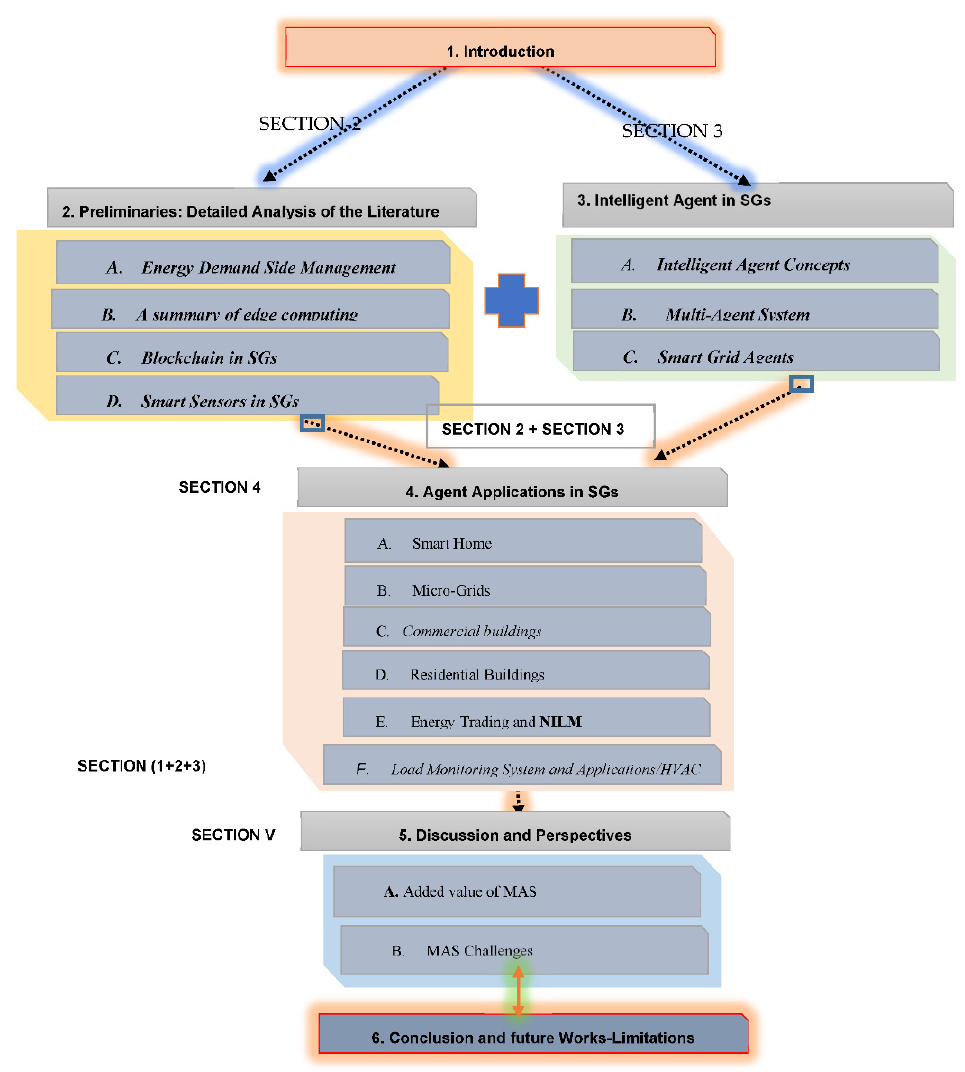
Figure 1. Description of survey paper sections.